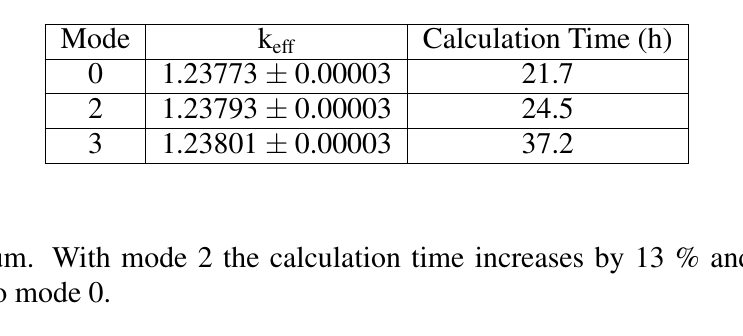
Table 1: Effective Multiplication Factors and Total Calculation